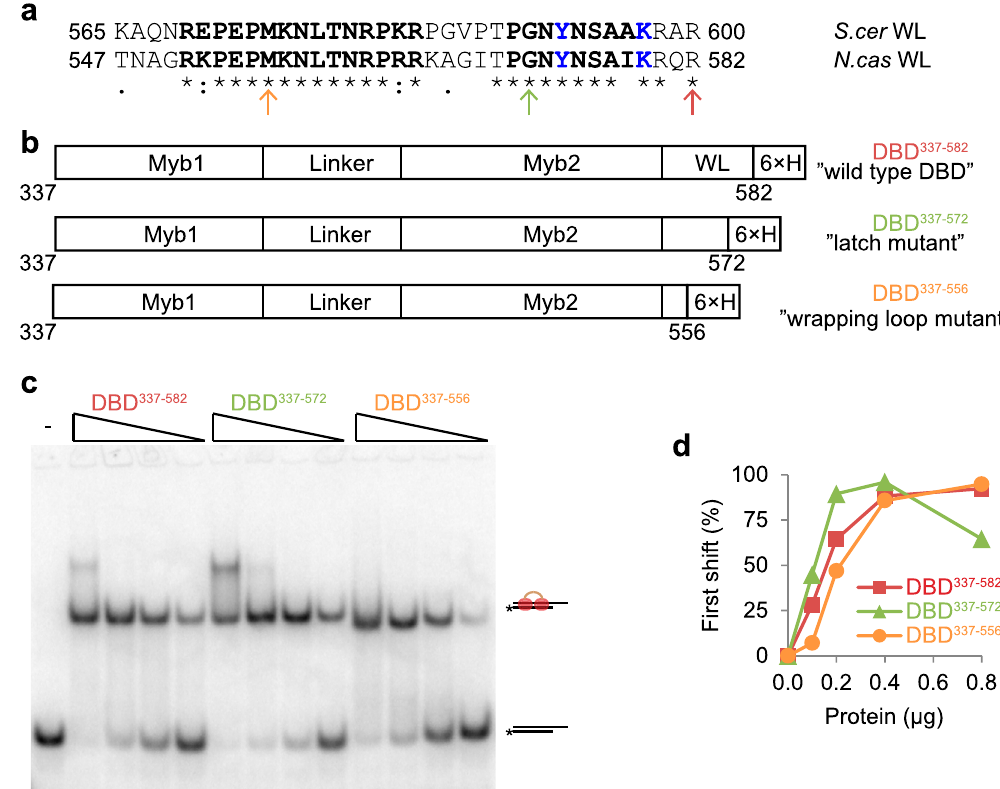
Figure 5. Design of N. castelli Rap1 DBD wrapping loop and latch mutants, and analysis of their DNA binding activities. ( a ) Sequence alignment (determined using uniprot CLUSTAL O(1.2.2) multiple sequence alignment tool) of the S. cer and N. cas wrapping loop. Amino acids of the S. cer sequence known to take part in DNA- interactions are shown in bold black text and amino acids interacting with the Myb1 domain are shown in blue. “ * ” Identical, “ : ” strongly similar, and “.” weakly similar amino acids. The numbers of the first and last amino acids in the wrapping loop are indicated. The last amino acid of each DBD variant is indicated by arrows; orange for “wrapping loop mutant” DBD 337–556 , green for “latch mutant” DBD 337–572 , red for “wild type” DBD 337–582 . ( b ) Schematic of the generated N. cas DBD deletion variants, containing two Myb-like domains (Myb1 and Myb2), separated by a linker region, varying lengths of the wrapping loop (WL), and a poly-histidine affinity tag (6&#x02E3;H). ( c ) EMSA with D17S9, using, 0.8; 0.4; 0.2; 0.1 μ g of the indicated DBD. “-’’ no protein added ( d